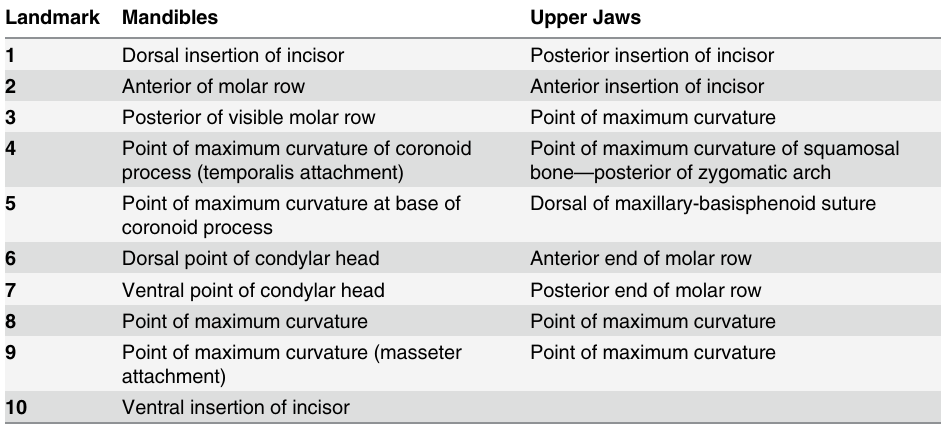
Table 2. Landmarks used for morphological